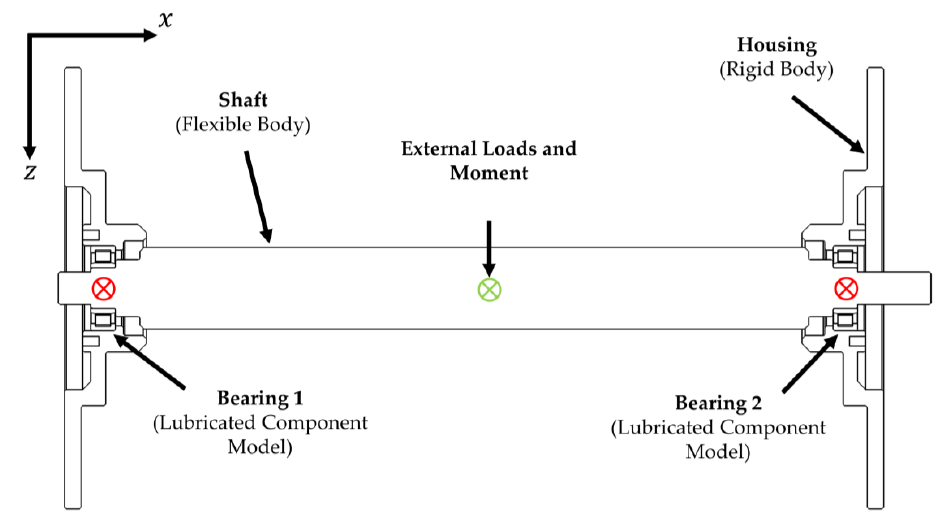
Figure 2. System Level Model Schematic.